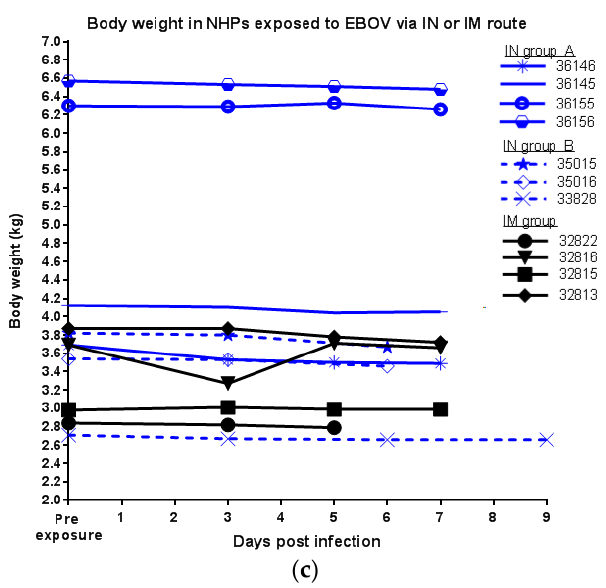
Figure 2. Clinical observations of EBOV infected NHPs exposed via IM or IN route; ( a ) clinical scores; ( b ) rectal temperature (°C); ( c ) body weight (kg).